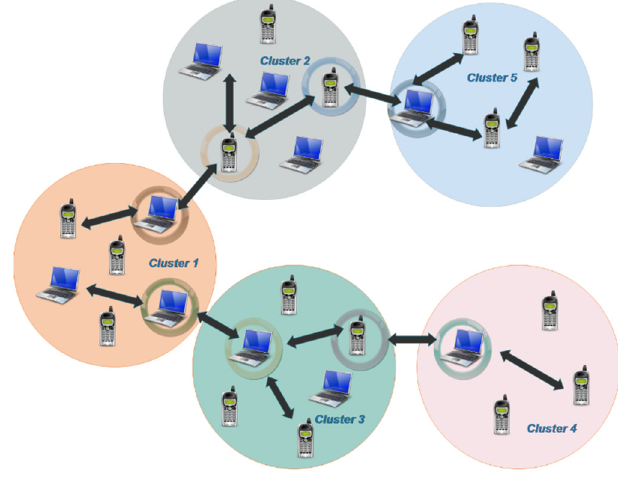
Figure 4. Cluster-based dynamic broker-selection process.